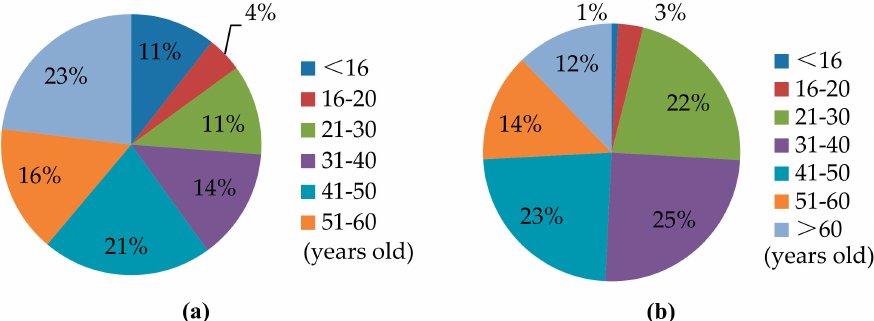
Figure 2. Age distribution of locals and migrants in Zhouzhuang in 2017: ( a ) Locals; ( b )